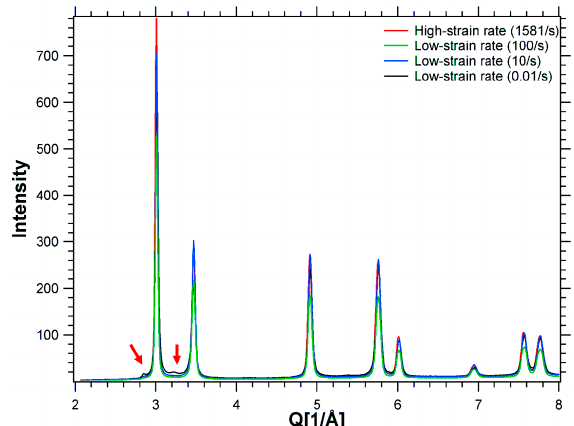
Figure 8. Diffraction profile of the four specimens deformed at different strain rates. Figure 8. Di ff raction profile of the four specimens deformed at di ff erent strain